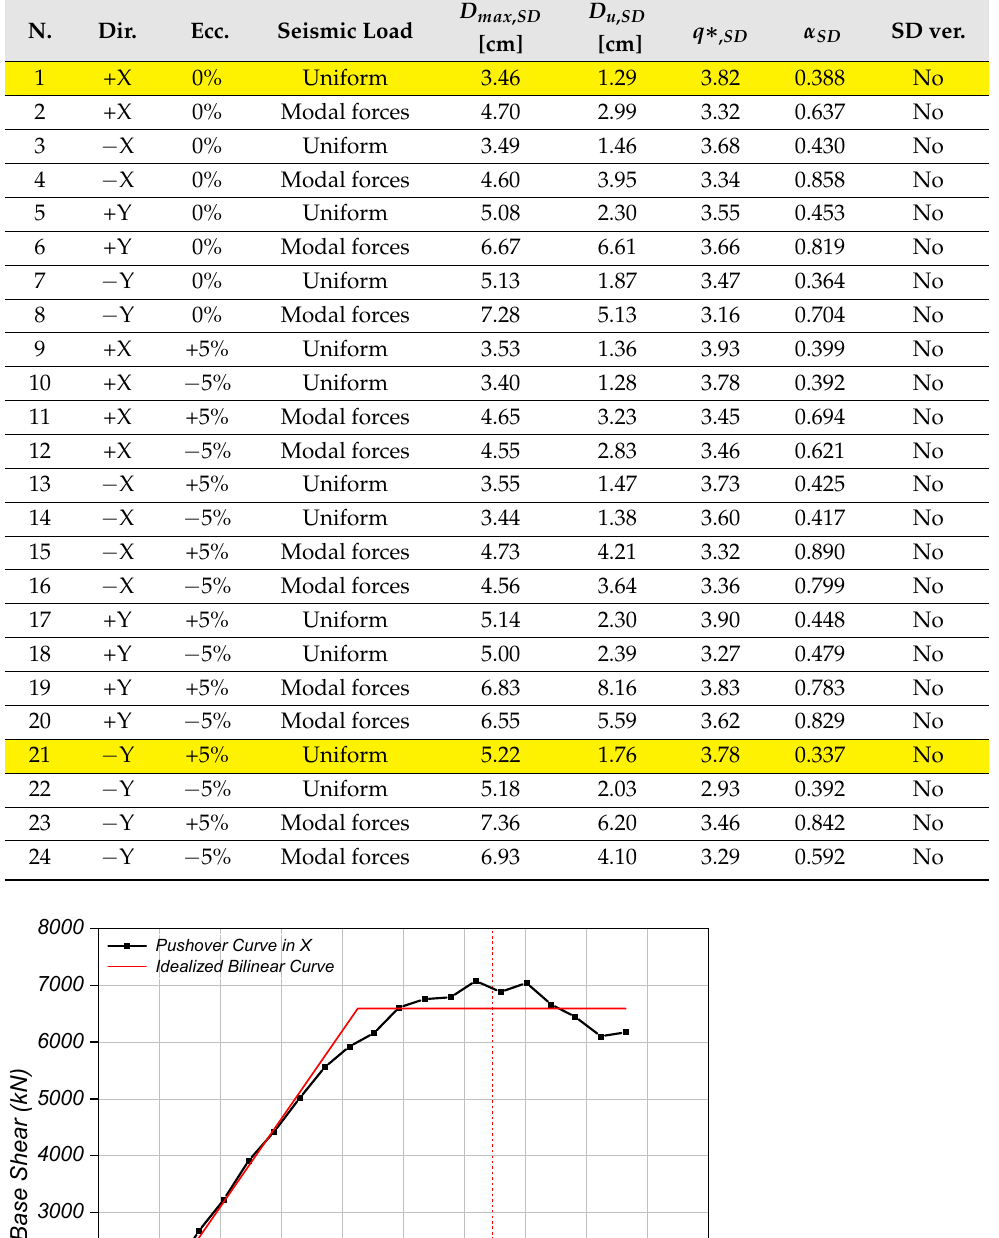
Table 4. Synthetic results of pushover analysis, control node n.219.